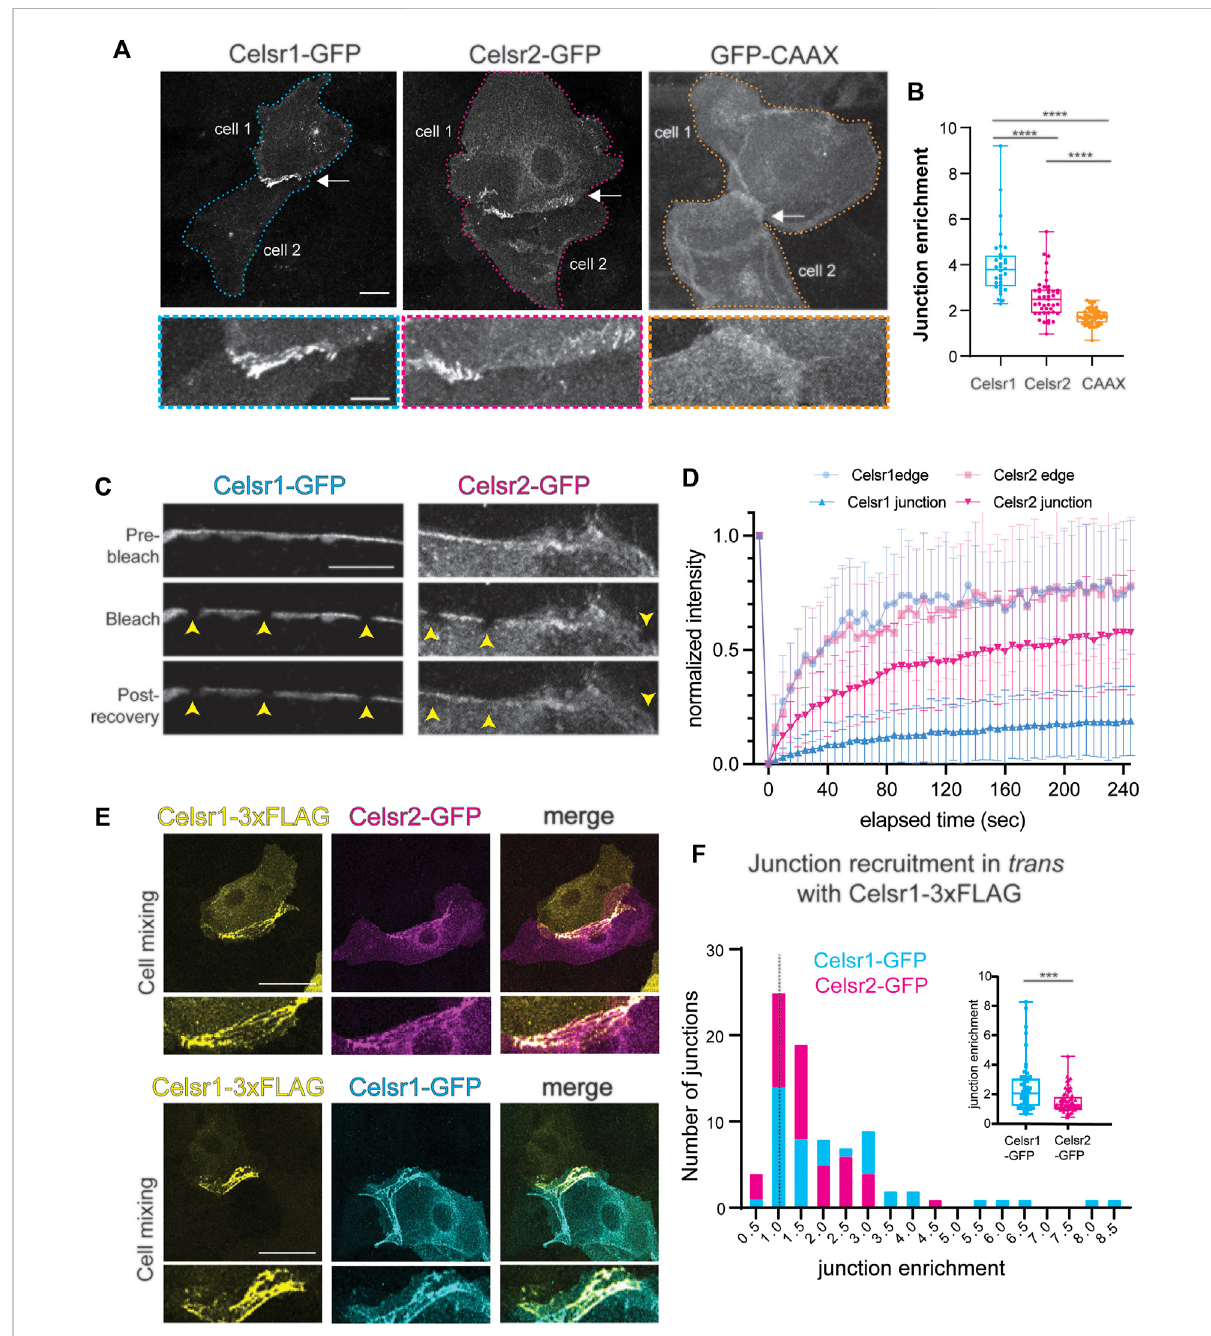
Celsr2 enriches at cell-cell junctions by homotypic interactions less ef fi ciently than Celsr1. (A) Representative images of cell pairs expressing Celsr1-GFP,Celsr2-GFPorGFP-CAAXasindicated.Bottompanels showzoomedinjunctionalregions.Notethestronger enrichmentofCelsr1-GFP at junctions compared to Celsr2-GFP and both isoforms are signi fi cantly more enriched at junctions compared to a non-junctional plasma membrane marker GFP-CAAX. Scale bars 20 µm (top panel) and 10 µm (bottom panel). (B) Plot of the junctional enrichment score (ratio of junctional mean intensity to the mean intensity of the cell pair). n = 32 Celsr1-GFP junctions, n = 43 Celsr2-GFP junctions, n = 60 GFP-CAAX junctions. Kolmogorov-Smirnov test p < 0.0001. Data pooled from two independent experiments where each experiment re fl ects the represented trend. (C) Fluorescence Recovery After Photobleaching (FRAP) of junctional Celsr1-GFP and Celsr2-GFP. Shown are representative images of the junctional region between cell pairs expressing Celsr1-GFP or Celsr2-GFP before and after bleaching as indicated. Bleached ROIs are marked by yellow arrowheads. (D) FRAP recovery plots. Shown is the normalized mean intensity with standard deviations of the bleach and recovery pro fi les plotted versus time for Celsr1-GFP (blue)and Celsr2-GFP(magenta) atjunctions(in bold) andfreecell edgesthat are not juxtaposed to atransfected cell (in lighter shade). (n = 36 ROIs for Celsr1 edge, 38 ROIs for Celsr2 edge, 78 ROIs for Celsr1 junctions and 75 ROIs for Celsr2 junctions). Data